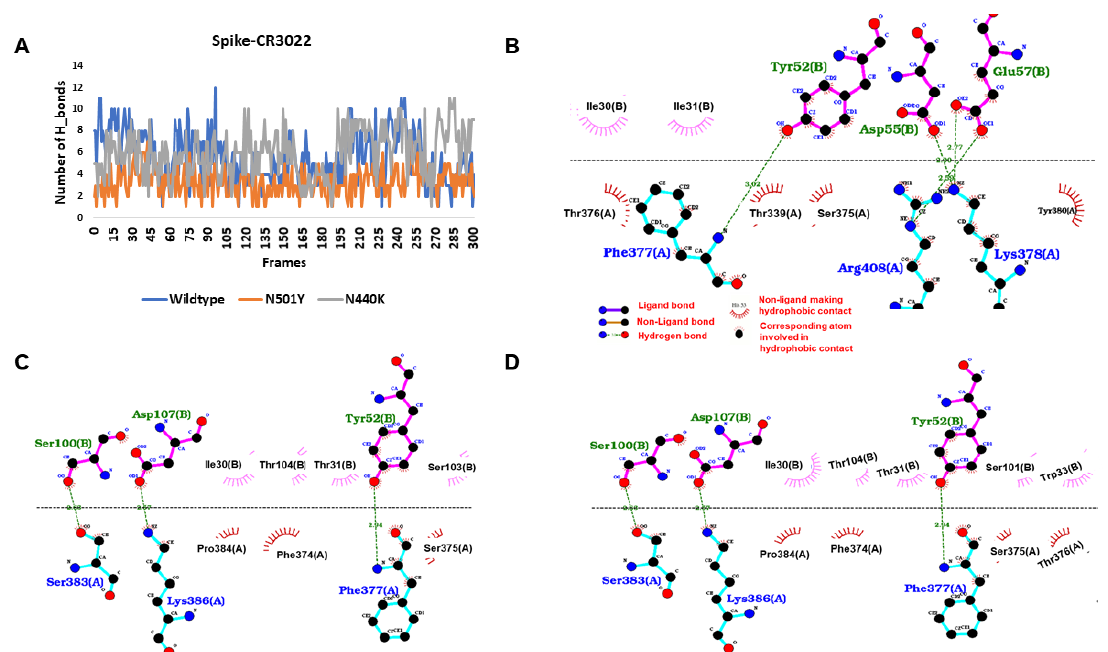
Figure 4. Binding interactions and energy of spike proteins with the CR3022 antibody. ( A ) The hydrogen interaction of wildtype was better than mutant spike proteins. ( B ) The binding interaction of wildtype spike protein with the heavy chain of CR3022 antibody, N501 (circled) making hydrophobic contact (hydrogen bonds are shown with green dots and non-polar interactions with magenta and brick semicircle). ( C ) The binding interaction of N501Y mutant spike protein with heavy chain of CR30222 antibody. ( D ) The binding interaction of N440K mutant spike protein with heavy chain of CR3022 antibody.